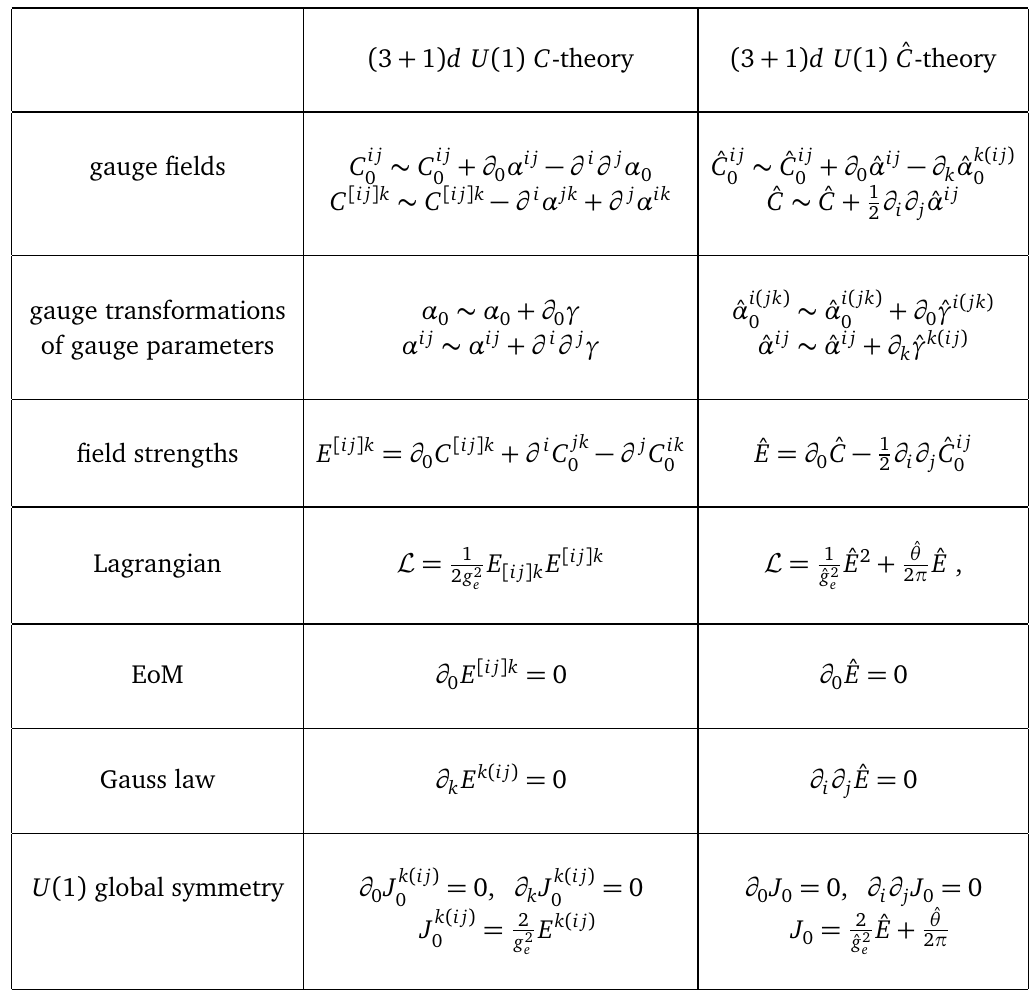
Table 5: The U ( 1 ) gauge theories of C in Section 5 and of ˆ C in Section